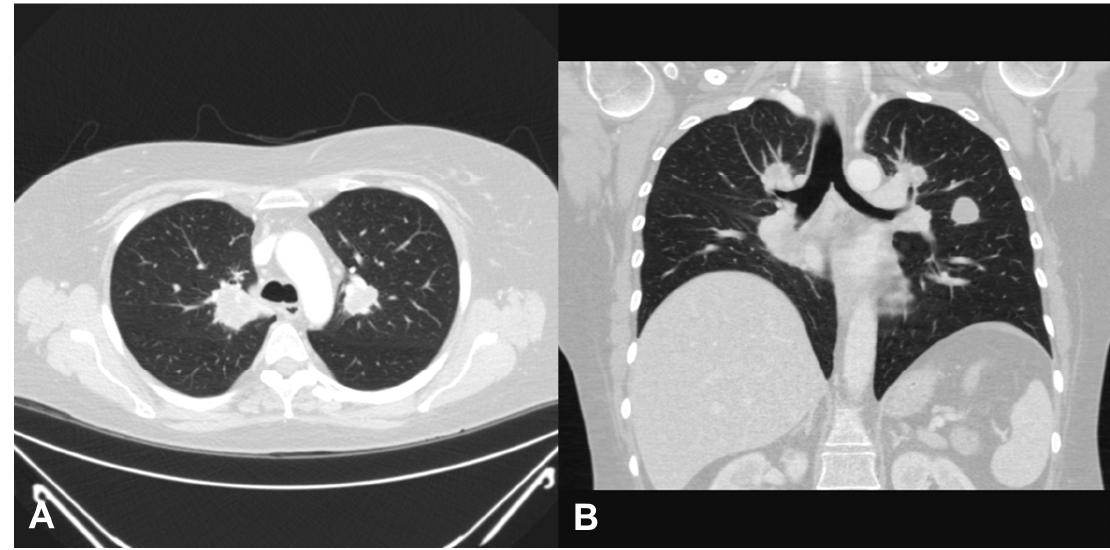
Figure 4. Chest computed tomography scan showed several round or lobular nodules with central necrosis in both lungs 2 years after surgery for subglottic stenosis ( A , axial view; B , coronal view).